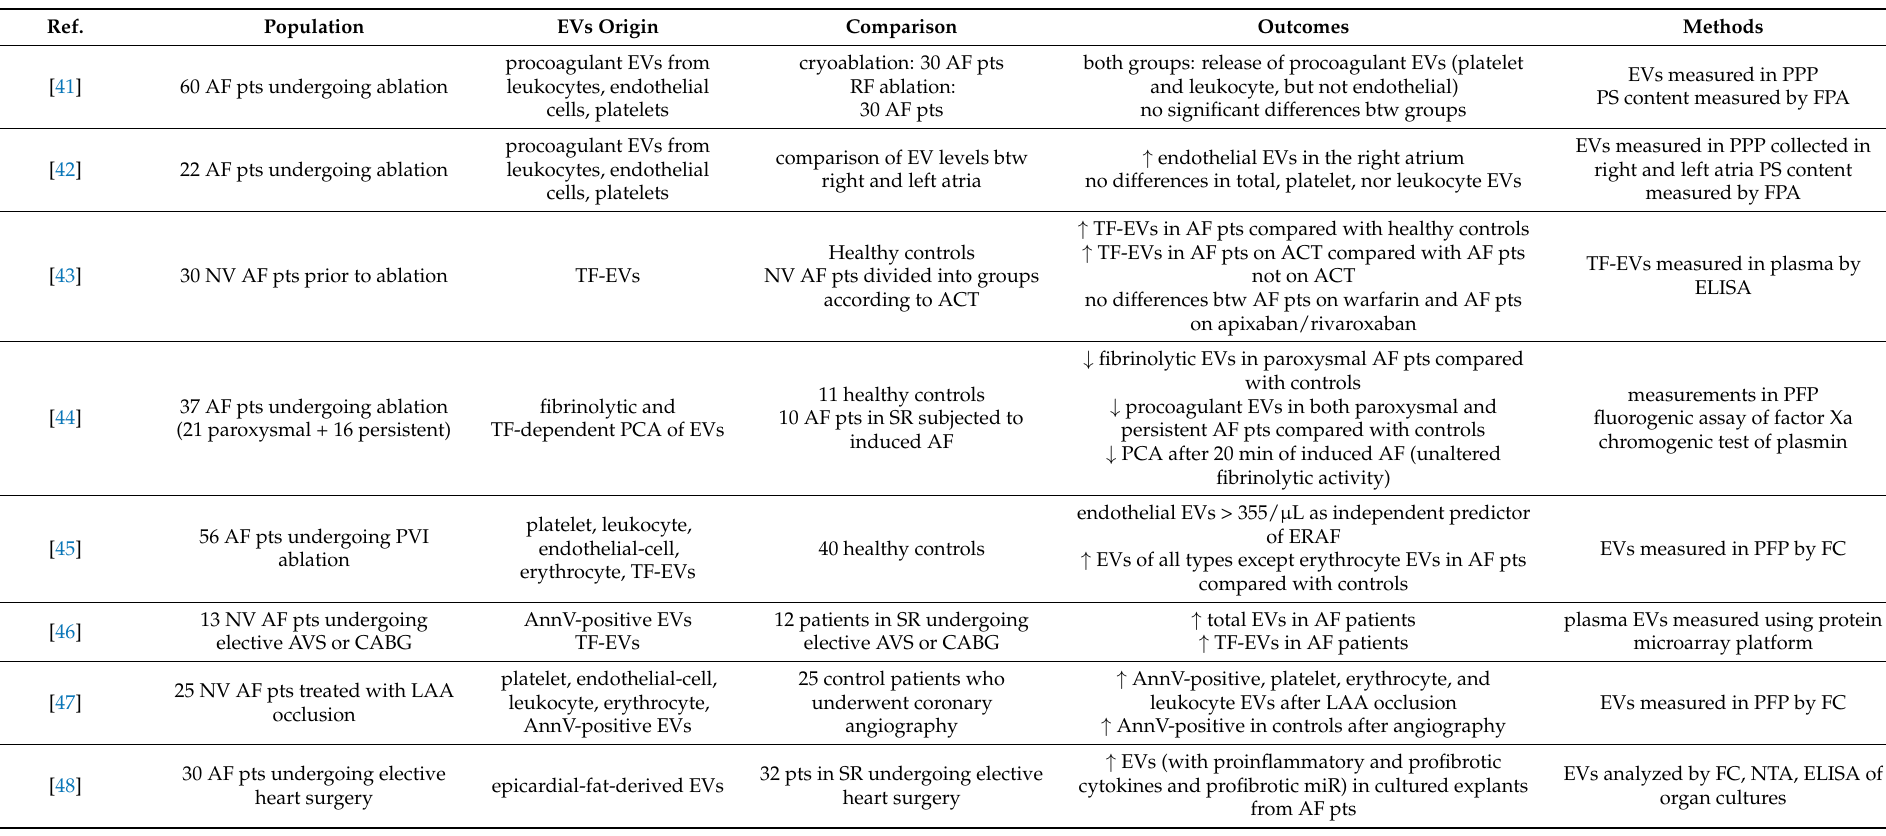
Table 3. Summary of recent studies regarding extracellular vesicles in atrial fibrillation patients undergoing ablation and other procedures.